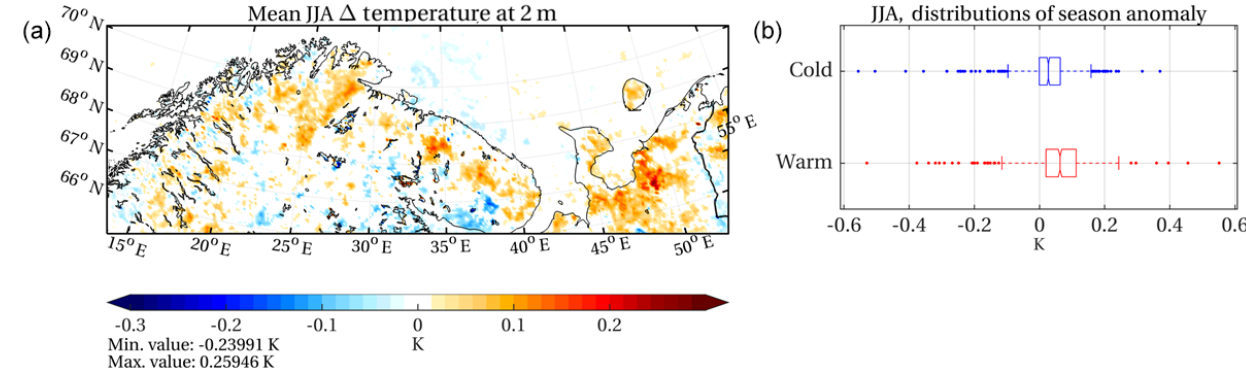
Figure 10. Difference (RefVeg warm –RefVeg cold ) in temperature response due to increased shrub cover (Veg0K–RefVeg; only showing significant results at the 95% confidence level, as in Fig. 4). The anomaly distribution across the domain is shown (panel (b) ). The red box shows warm season anomalies and the blue box shows cold season anomalies in areas with vegetation changes.